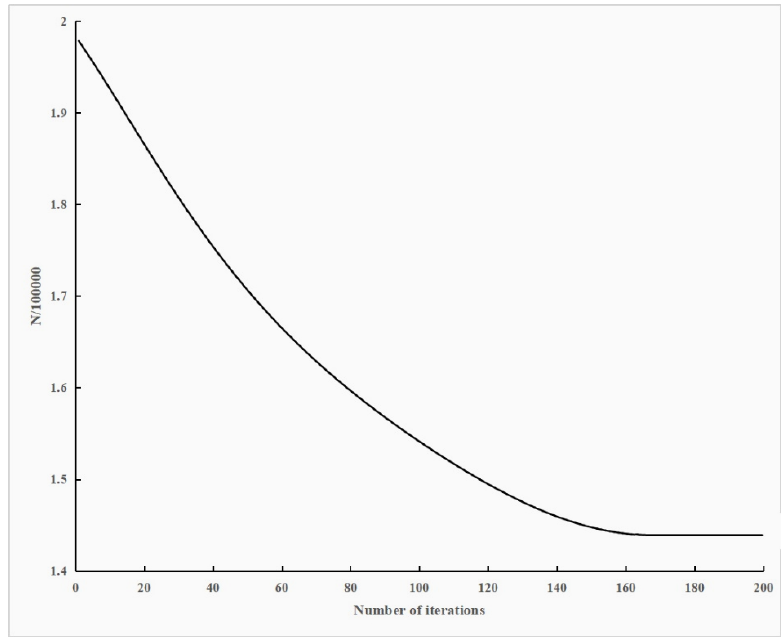
Figure 10. Optimizing process.